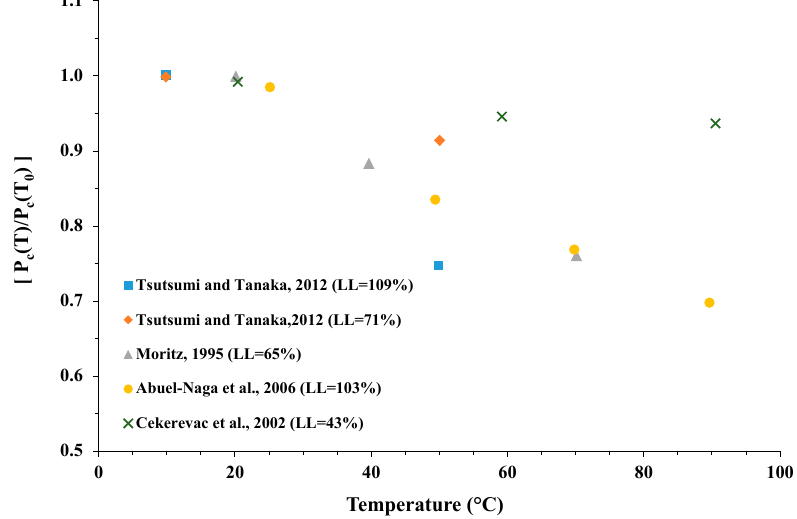
Figure 3. Effect of temperature on preconsolidation pressure.